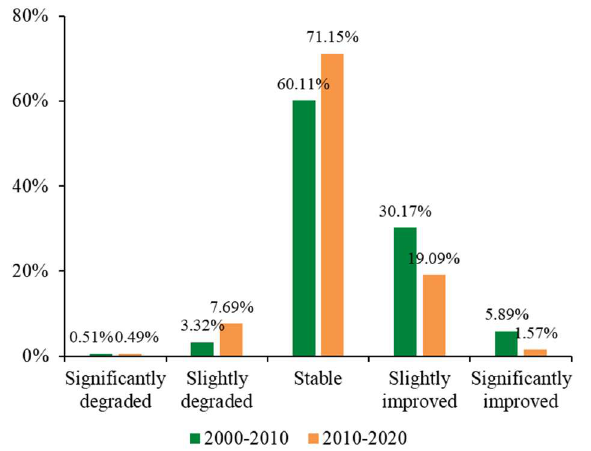
Figure 8 . The proportion of changes in ecological environment